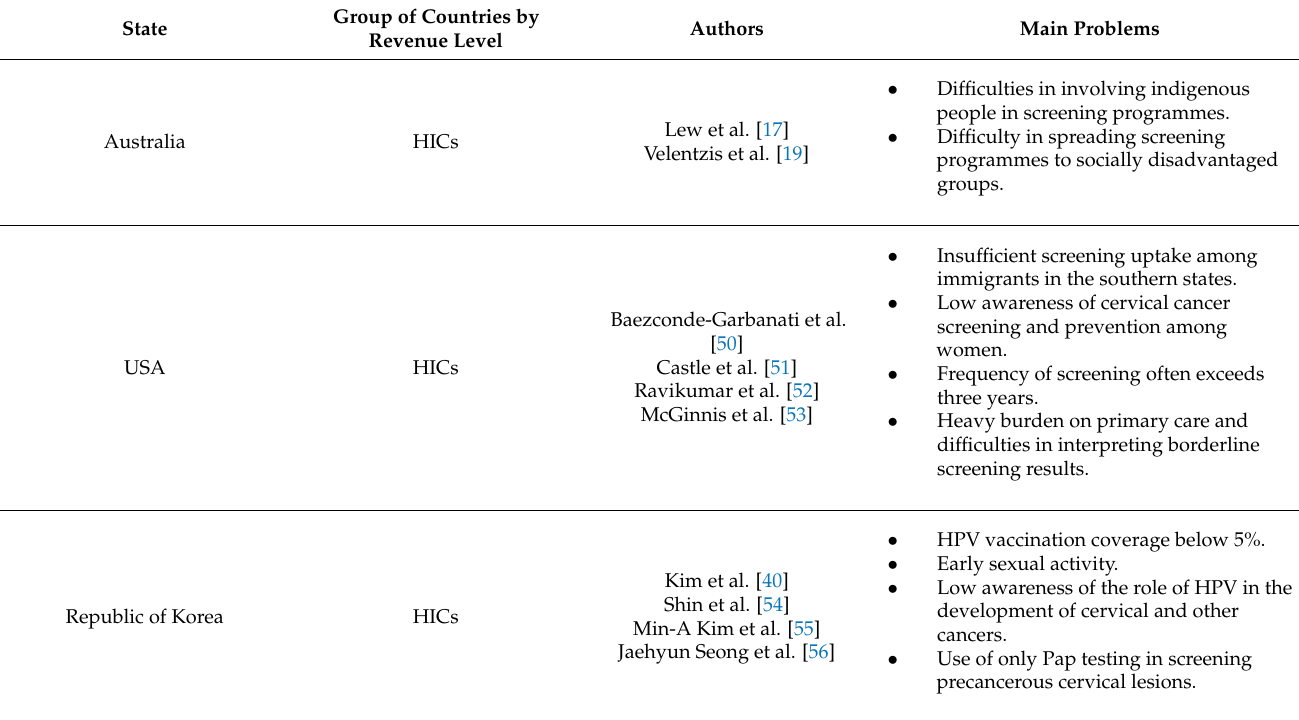
Table 1. Problems facing countries with different revenue levels in implementing the Global Strategy to Accelerate the Elimination of Cervical Cancer as a Public Health